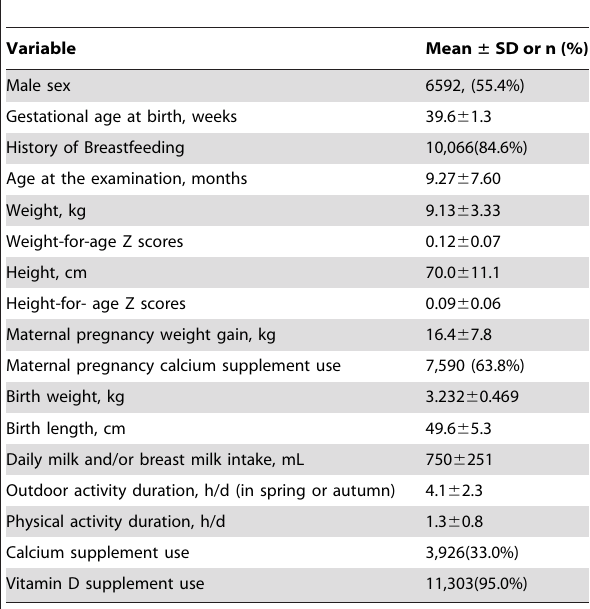
Table 2. BMD values of term children aged 0 , 3 years (g/cm 2 ) (Mean 6 SD).